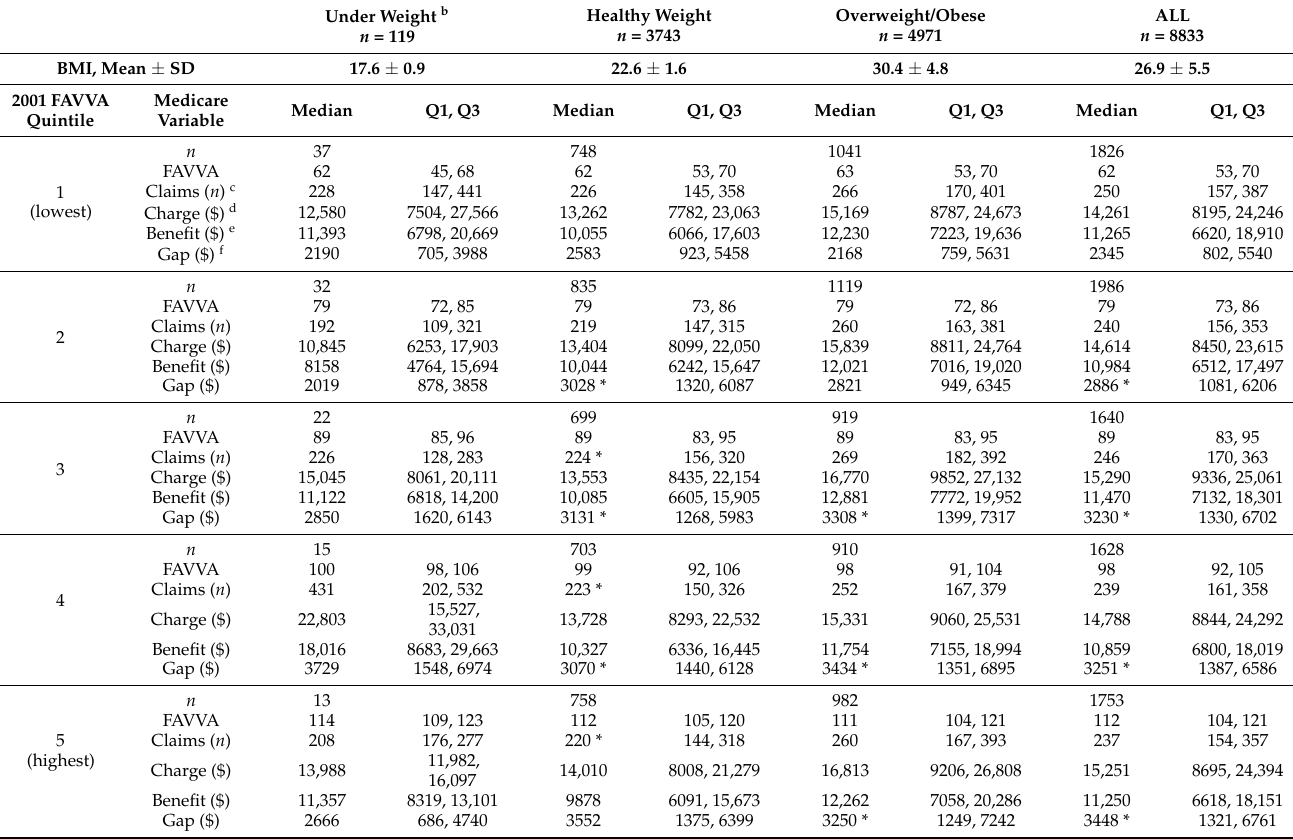
Table 2. Median 15-year (2001–2015) cumulative Medicare claims and costs ($AU) for Australian women born in 1946–1951 by the quintile of the baseline FAVVA score (1 = lowest and 5 = highest FAVVA quintiles) and baseline BMI category ( n = 8833) a . Under Weight b n =